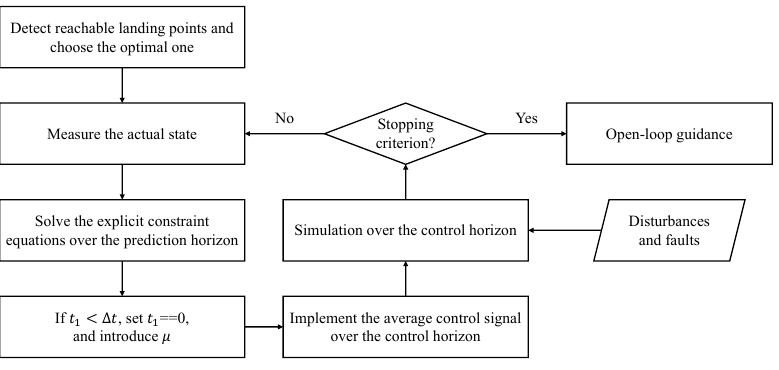
Figure 8. MPC flow